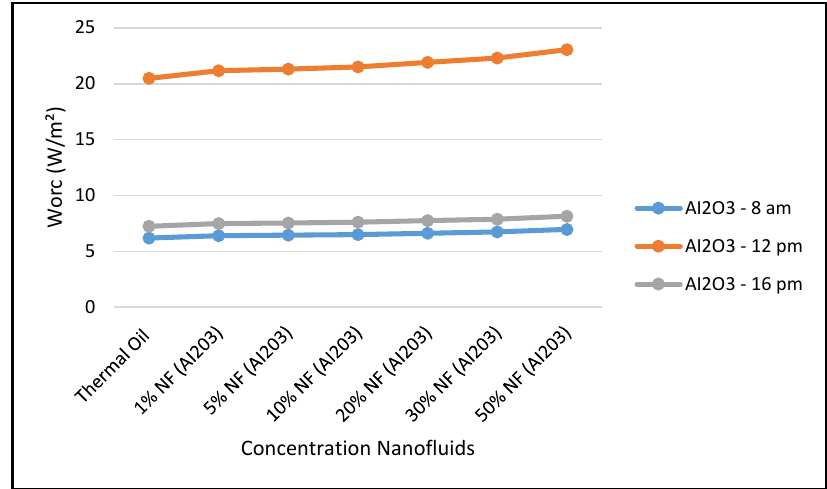
Appl. Syst. Innov. 2019 , 2 , x FOR PEER REVIEW Figure 12. Work produced by ORC at different concentrations of Al 2 O 3. Figure 12. Work produced by ORC at di